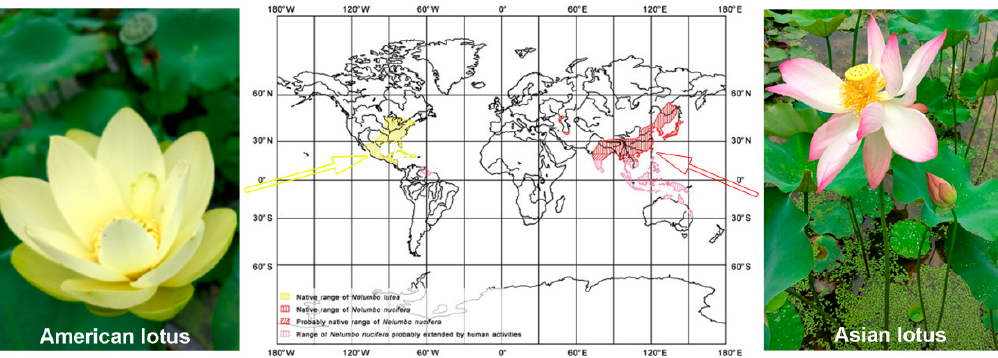
Figure 1. Overview of the lotus species and their global distribution. The left and right panels show the flowers of American and Asian lotus, respectively. The yellow and red shadow areas in the world map of the middle panel show the distributions of American and Asian lotus, respectively. (Figure revised from Li, Y. et al. [4]).